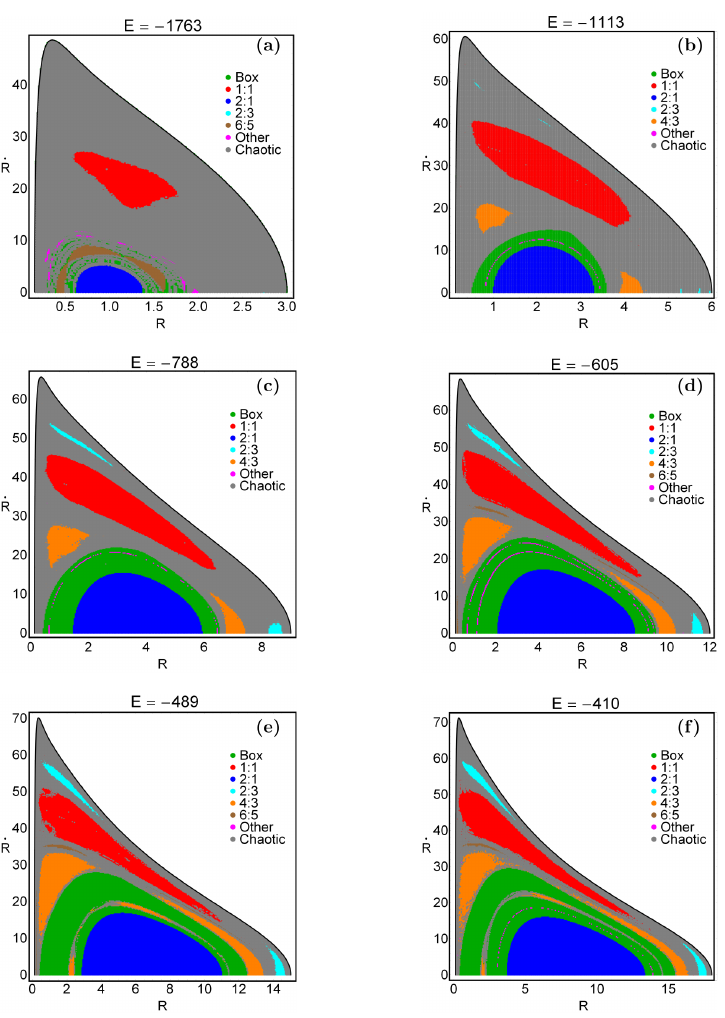
Fig. 2. Orbital structure of the phase plane ( R; ˙ R ) of our disk galaxy model for different values of the total orbital energy E